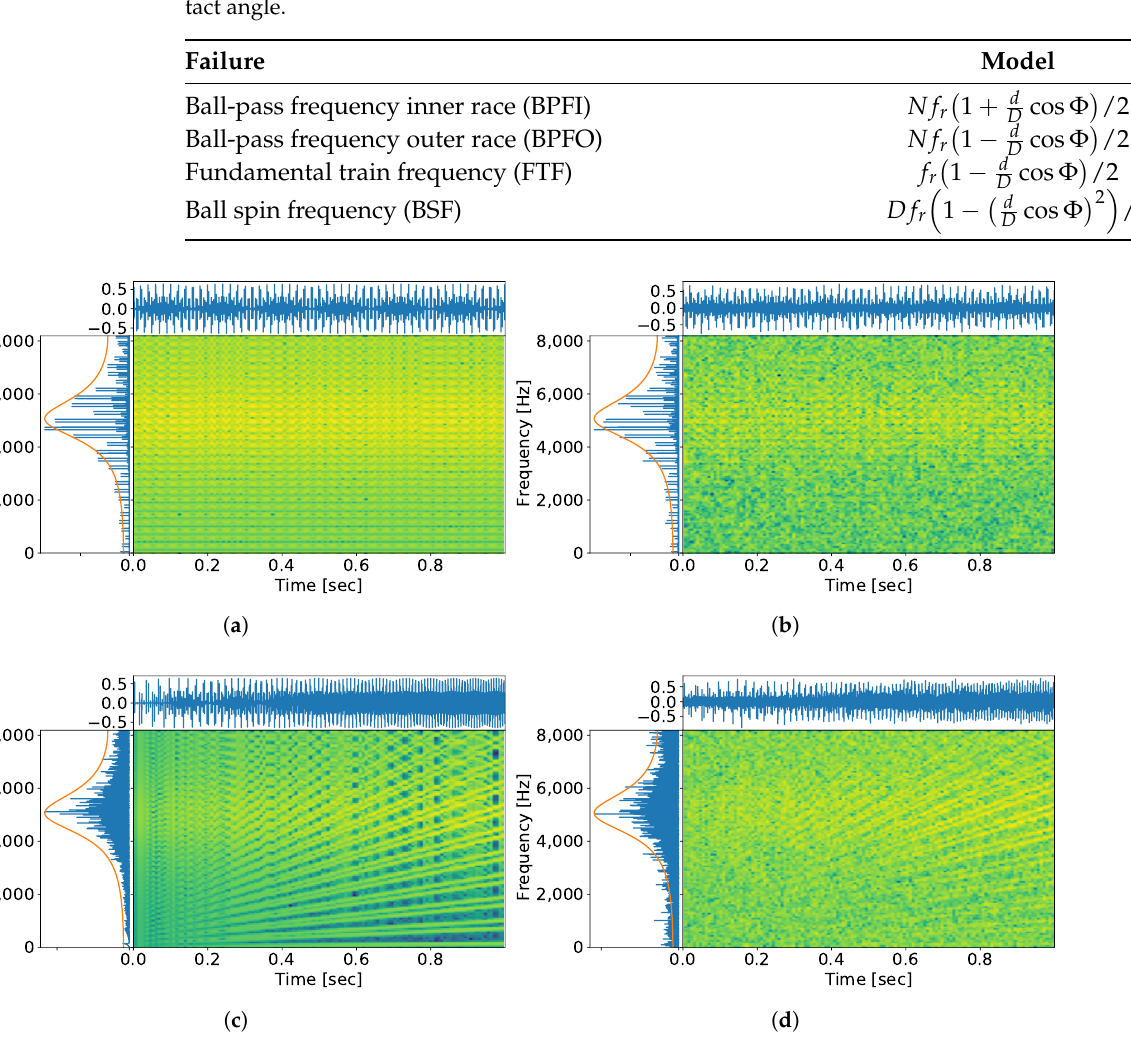
Figure 2. Modeling of REB failures. Figures in top row ( a , b ) show the spectrograms estimated for constant IAS and the figures bottom row ( c , d ) show the spectrogram of time-varying IAS. Left-hand side, corresponding plots of the clean signal; right-hand side, signal perturbed by noise at 3